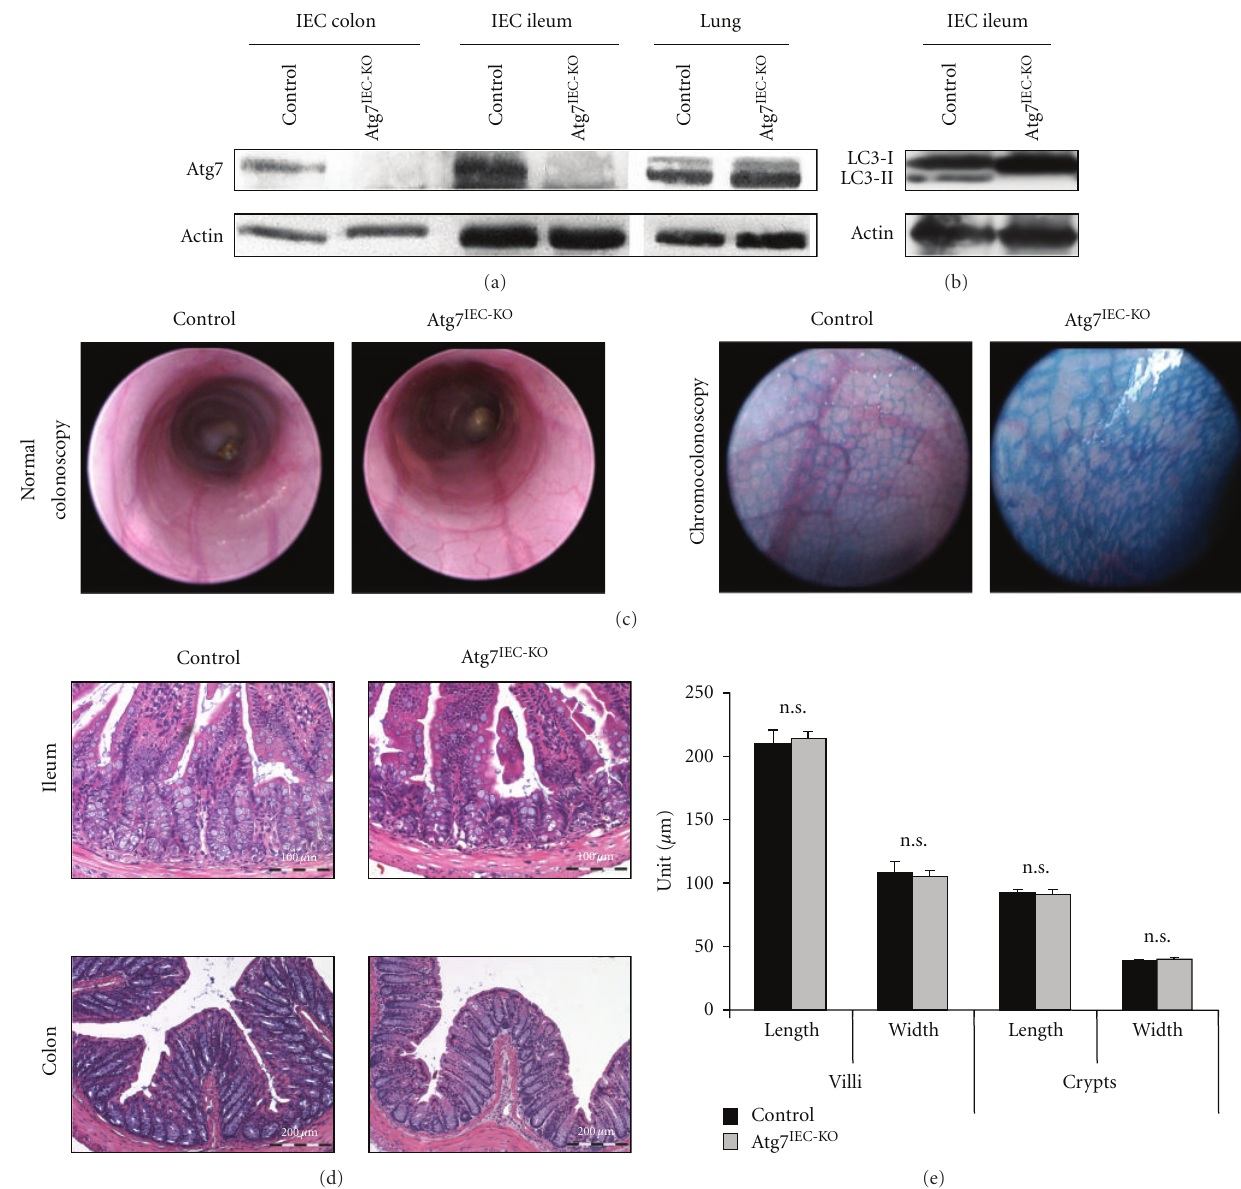
Figure 1: Gut characteristics in unchallenged control and Atg7 IEC-KO mice. (a) Western blot of proteins derived from unchallenged control and Atg7 IEC-KO mice demonstrating lack of Atg7 in isolated intestinal epithelial cells of colon and ileum from Atg7 IEC-KO mice. Other tissues of Atg7 IEC-KO mice display normal Atg7 expression (lung is shown as an example). Actin serves as an internal control. (b) Western blot of proteins extracted from isolated IECs of unchallenged control and Atg7 IEC-KO mice demonstrating deficient autophagy in Atg7-deficient IECs (indicated by lack of the LC3-II form). Actin serves as an internal control. (c) Representative pictures from colonoscopic video analysis using normal colonoscopy (left) and chromocolonoscopy with methylene blue (right) to visualize crypt structures. (d) Representative pictures of para ffi n-embedded ileum and colon cross sections stained with H & E. (e) Statistical analysis of distal ileum villi and crypts. Data show mean values of length and width + SEM ( n = 13 control villi, n = 24 Atg7 IEC-KO villi, n = 24 control crypts, n = 27 Atg7 IEC-KO